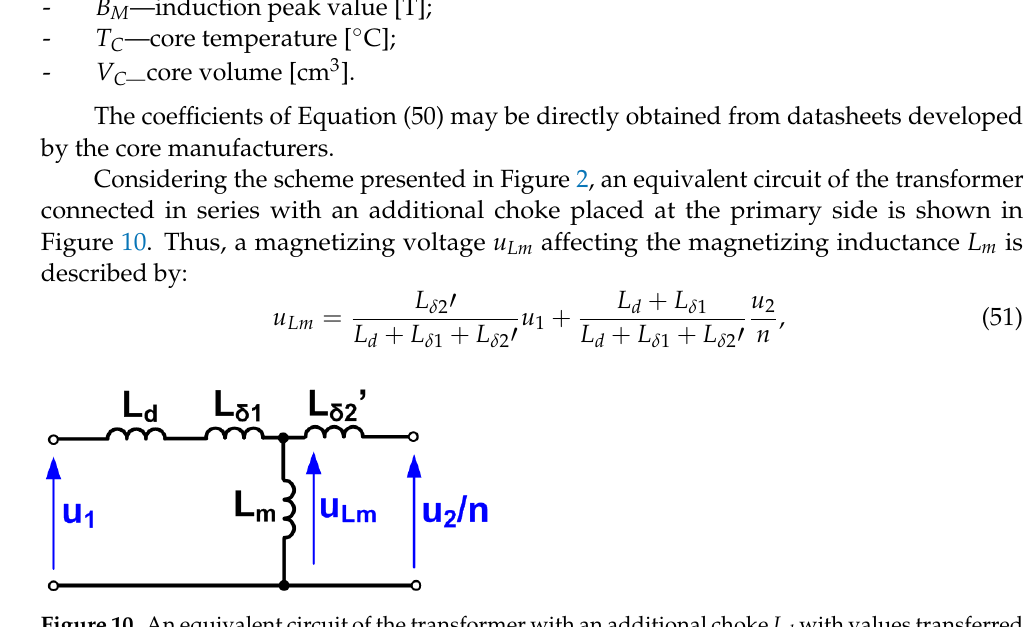
Figure 10. An equivalent circuit of the transformer with an additional choke L d with values transferred to the DAB H 1 bridge side.